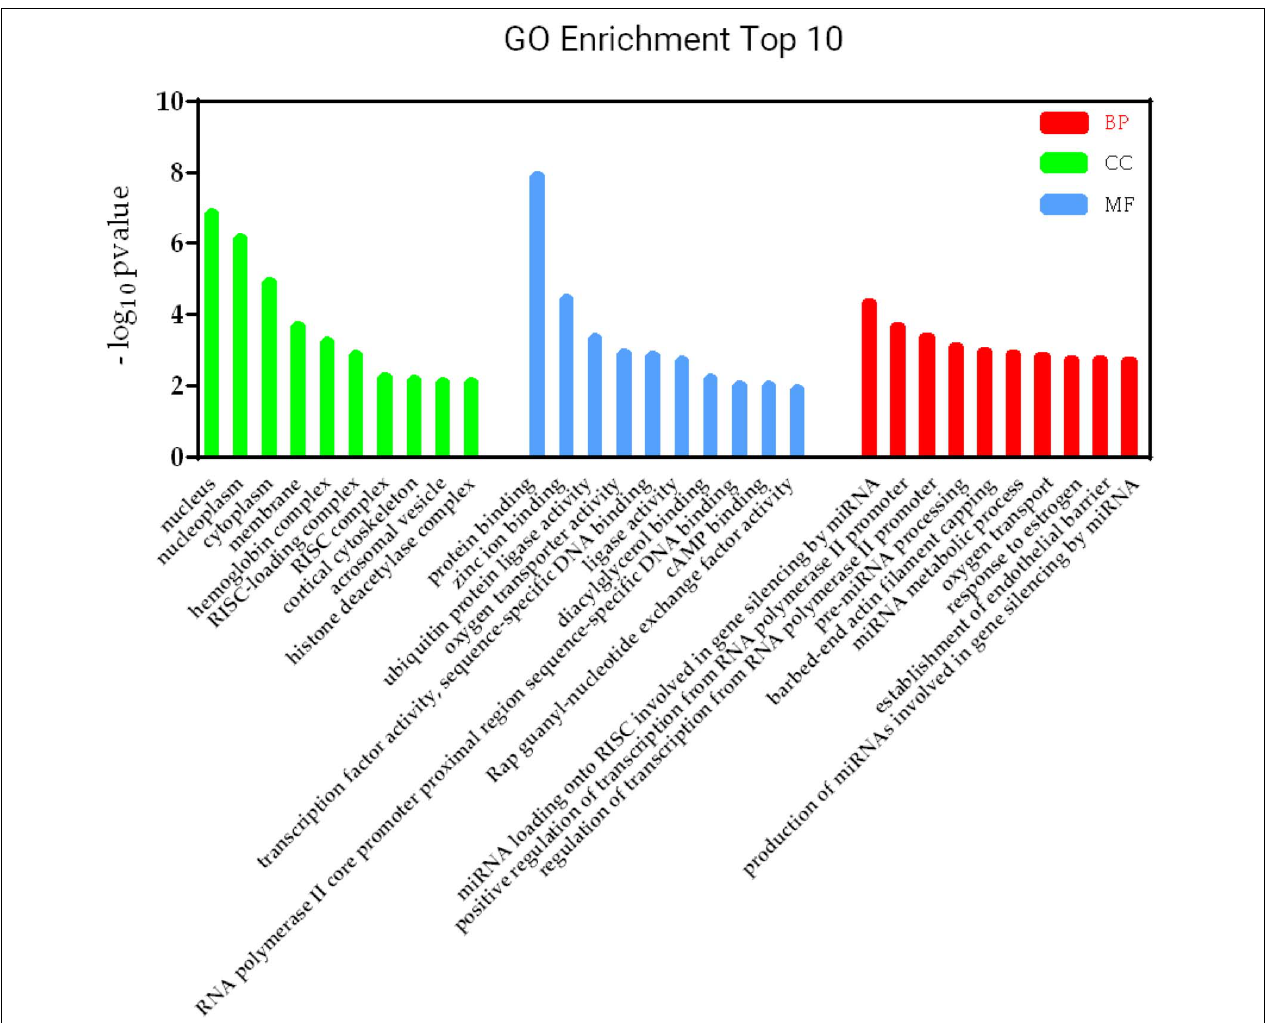
FIGURE 7 | GO terms involved in lncRNA-mRNA interaction network in SAPHO syndrome. The top 10 significant GO terms in biological process are shown in red, while those in cellular component in green and molecular function in